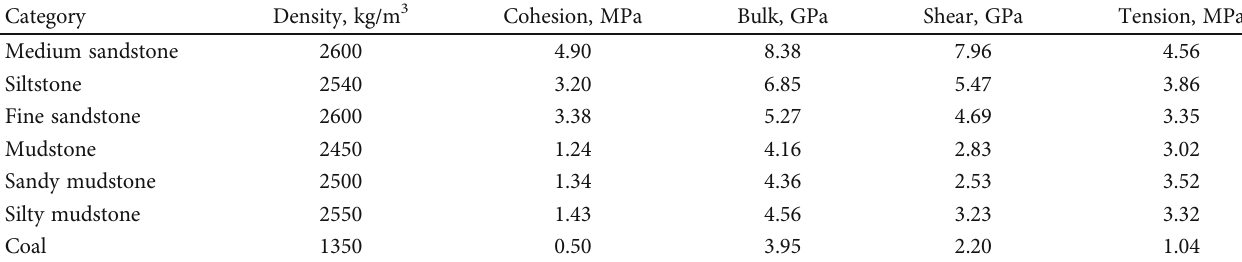
Table 1: Parameters for di ff erent rocks tested.